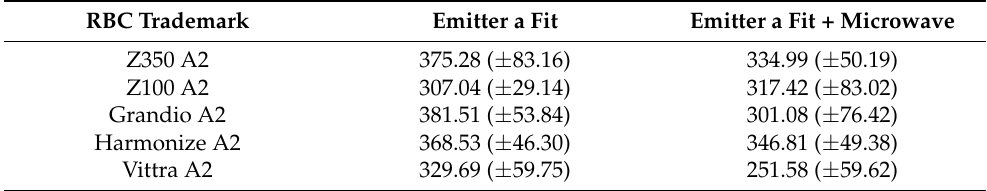
Table 5. Mean and standard deviation of the biaxial flexure strength test (in N) of each resin-based composite (shade A2) cured with a second-generation LED unit and microwave.